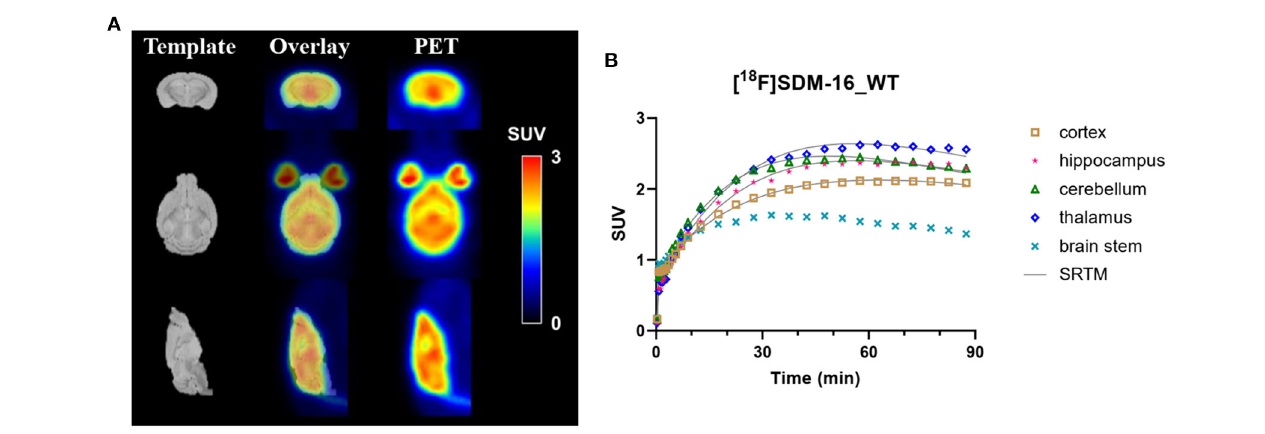
FIGURE1 (A) Representative summed SUV (0–60min) images of [ 18 F]SDM-16 in a wild-type (WT) mouse brain and the overlaid images with an MR template. (B) The time-activity curves of [ 18 F]SDM-16 in selected brain regions (cortex, hippocampus, cerebellum, thalamus, and brain stem) of a WT mouse. Solid lines are SRTM-fitted curves, using brain stem as the reference region.